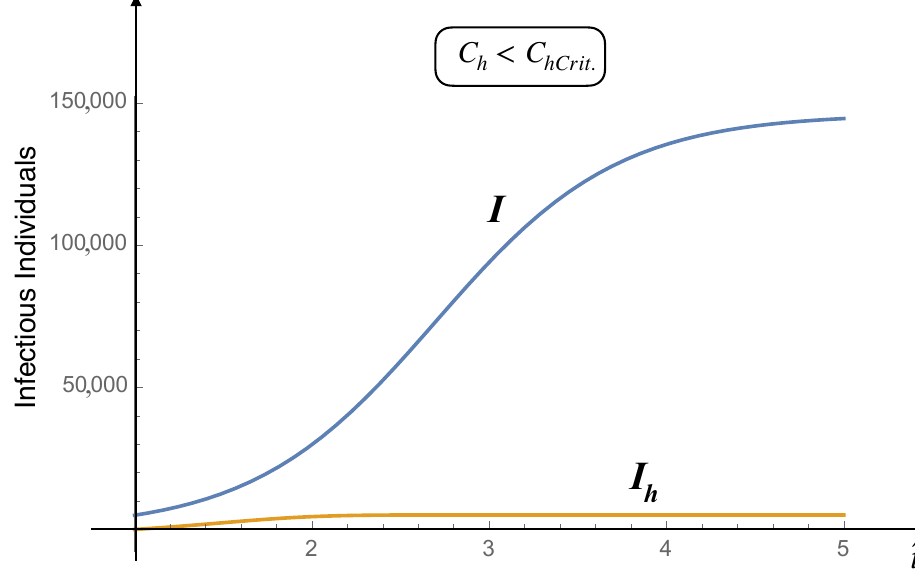
Figure 16. Infectious people and infectious hospitalised people vs. time - C h > C HCrit . . In this case, there is an epidemic outbreak with an increase of the number of the infectious people. The values of the parameters are: β = 0, k 1 = 0.00001, ρ = 0.0001, K 1 = 150,000, γ = 0.0001, σ = 2.7651, and C h =